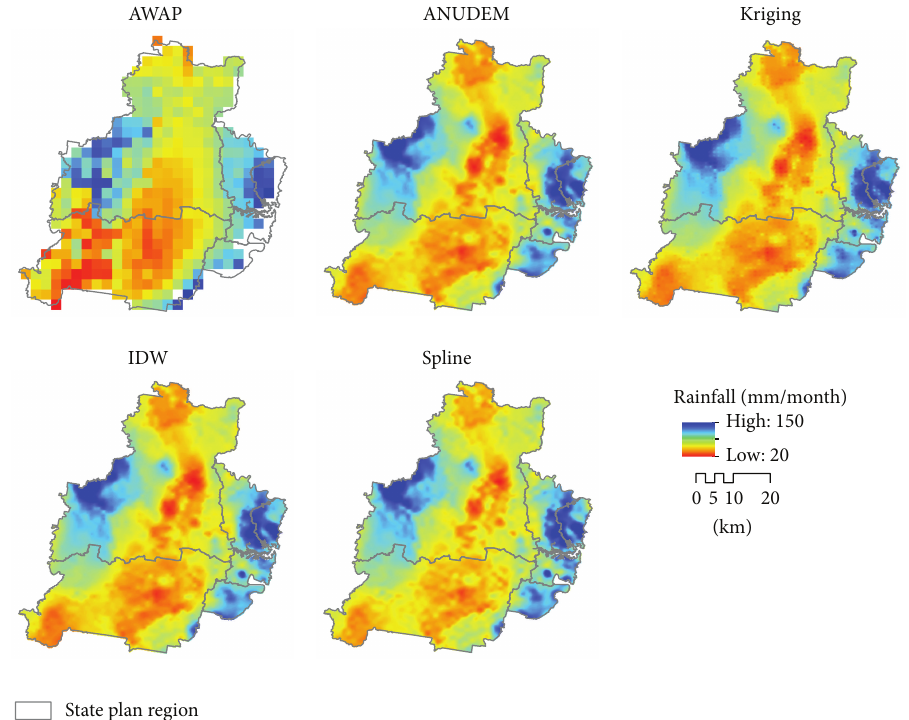
Figure 3: Comparison of interpolation methods for mean monthly rainfall against AWAP.